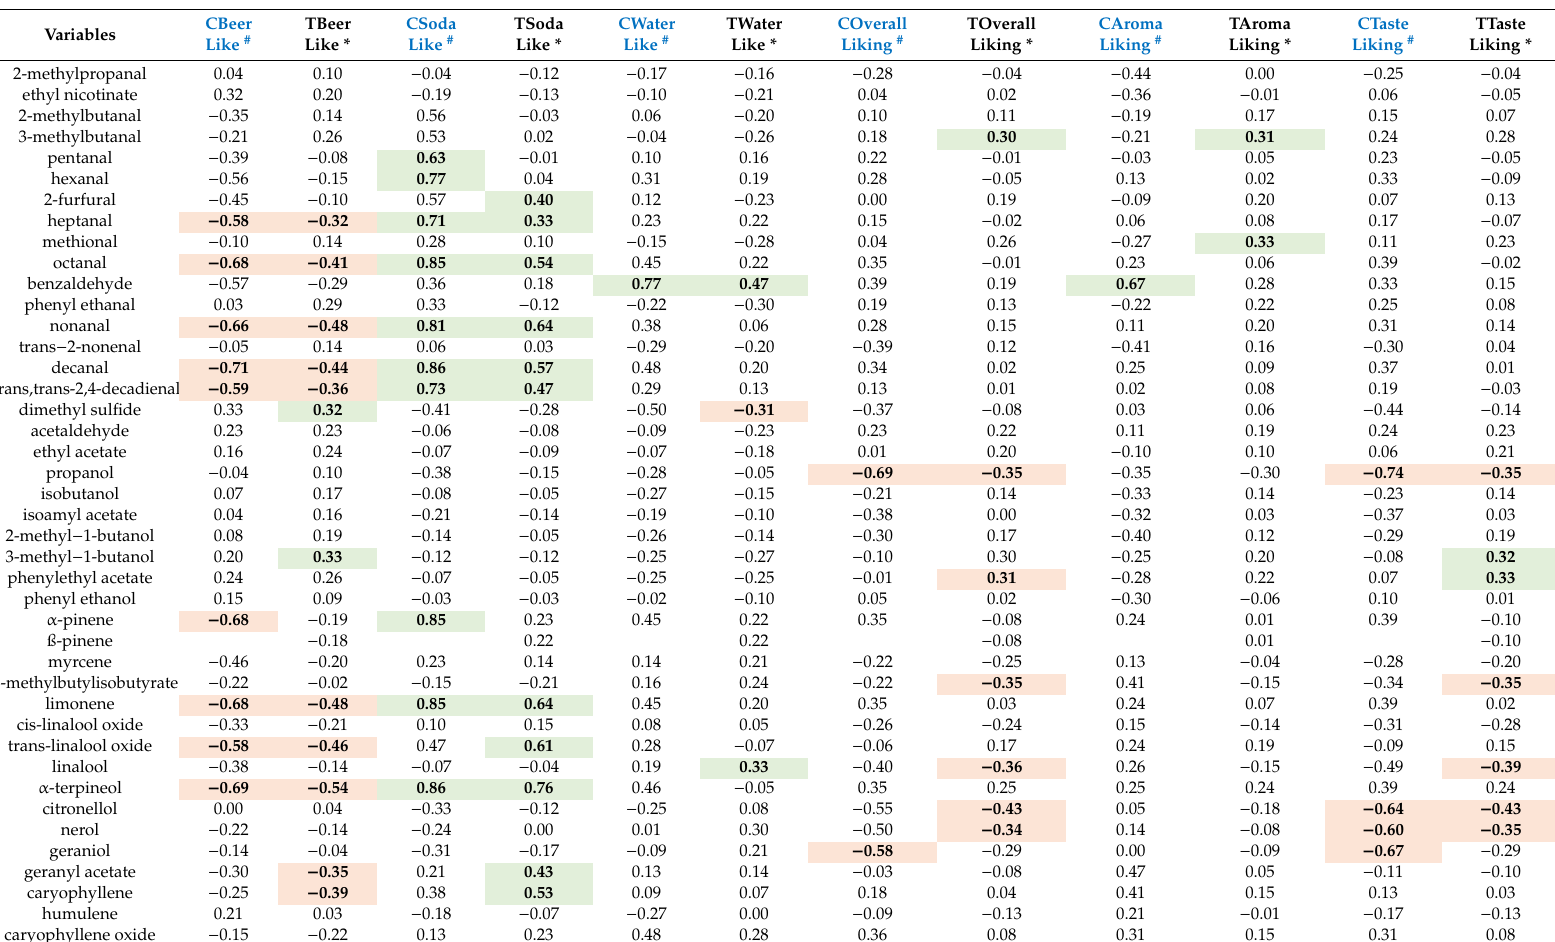
Table4. Pearsoncorrelationmatrixofleastsquaremeansforboththetrainedandconsumerpanelbeer, soda, watersimilarityratings, hedonicdata,